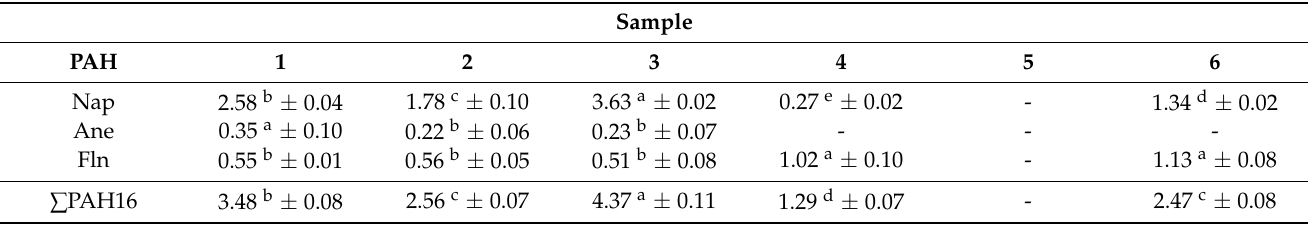
Table 1. PAH content ( µ g/kg) in different popcorn corn varieties in year 2019.